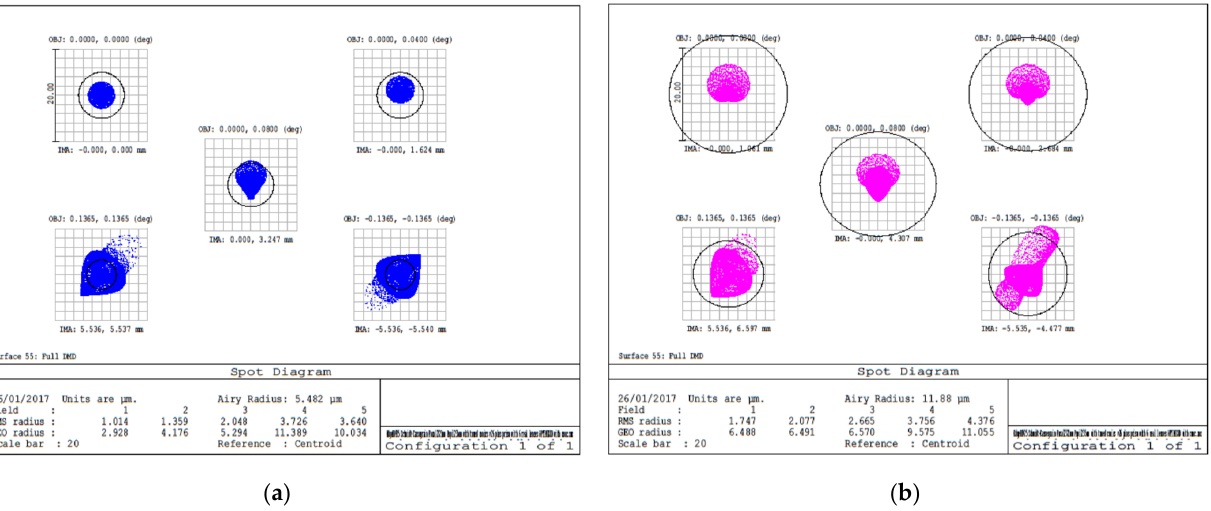
Figure 6. Spot diagram on the image plane (DMD surface) for different angles in the instrument field of view: ( a ) spot diagram at 300 nm, and ( b ) spot diagram at 650 nm.